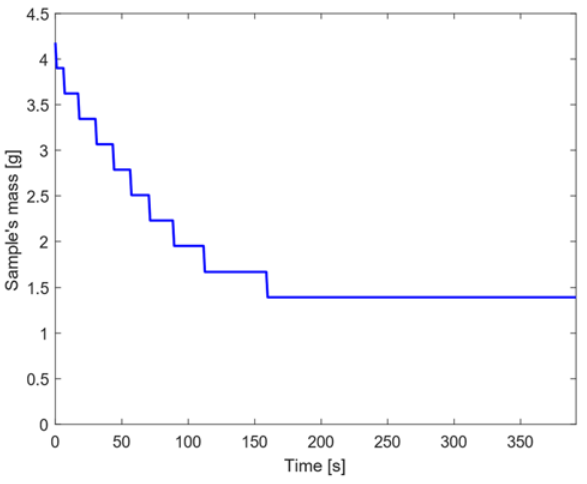
Figure 12. Sample’s mass decrease for CFRP when high heat flux is considered.